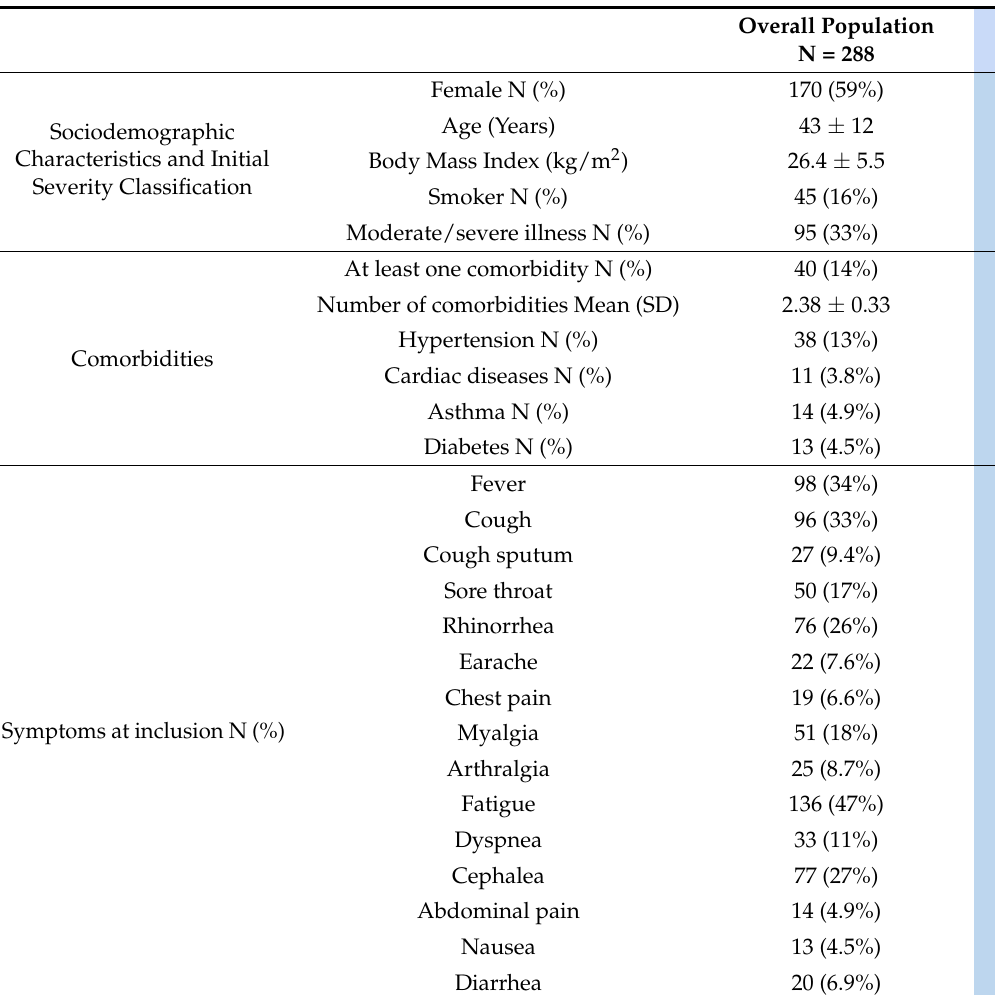
Table 1. Participants’ characteristics in the overall study population and by